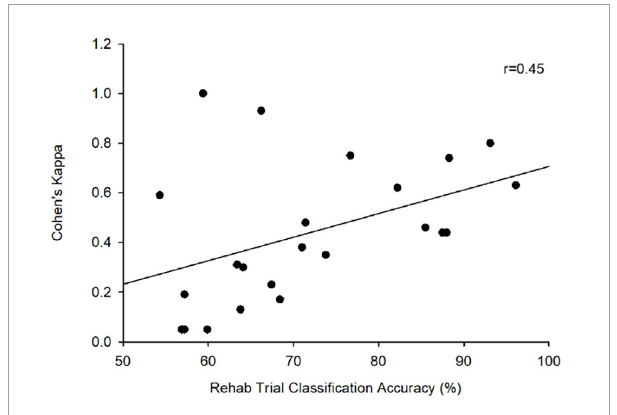
FIGURE3 Cohen’s Kappa vs. rehabilitation classification accuracy ( r = 0.45, p <